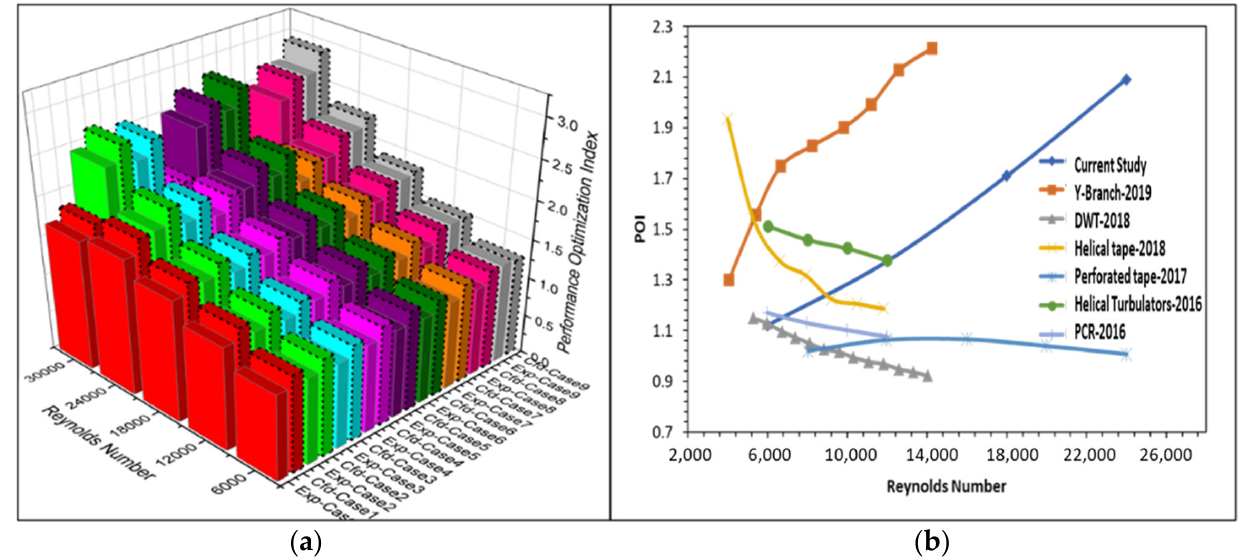
Figure 17. ( a ) POI of different experimental and computational case studies, and ( b ) Comparison of POI with present and past investigations.